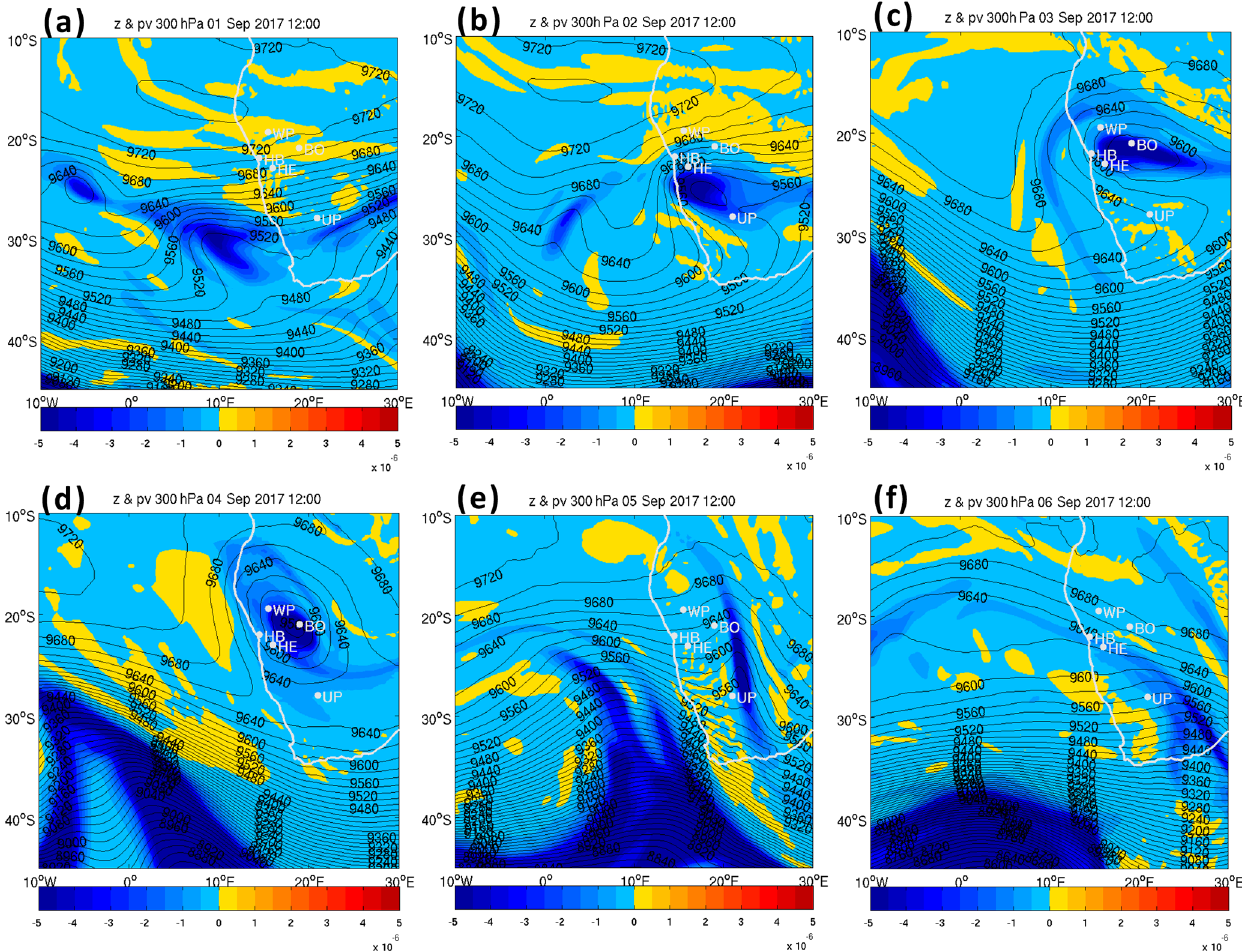
Figure 3. Geopotential (m, contours) and potential vorticity (Km 2 kg − 1 s − 1 , color) at 300hPa at 12:00UTC on (a) 1 September, (b) 2 September, (c) 3 September, (d) 4 September, (e) 5 September and (f) 6 September 2017 from ERA5 reanalysis. The names of the instrumented sites appear in white (from north to south): WP is Windpoort, BO is Bonanza, HB is Henties Bay, HE is HESS (Namibia) and UP is Upington (South